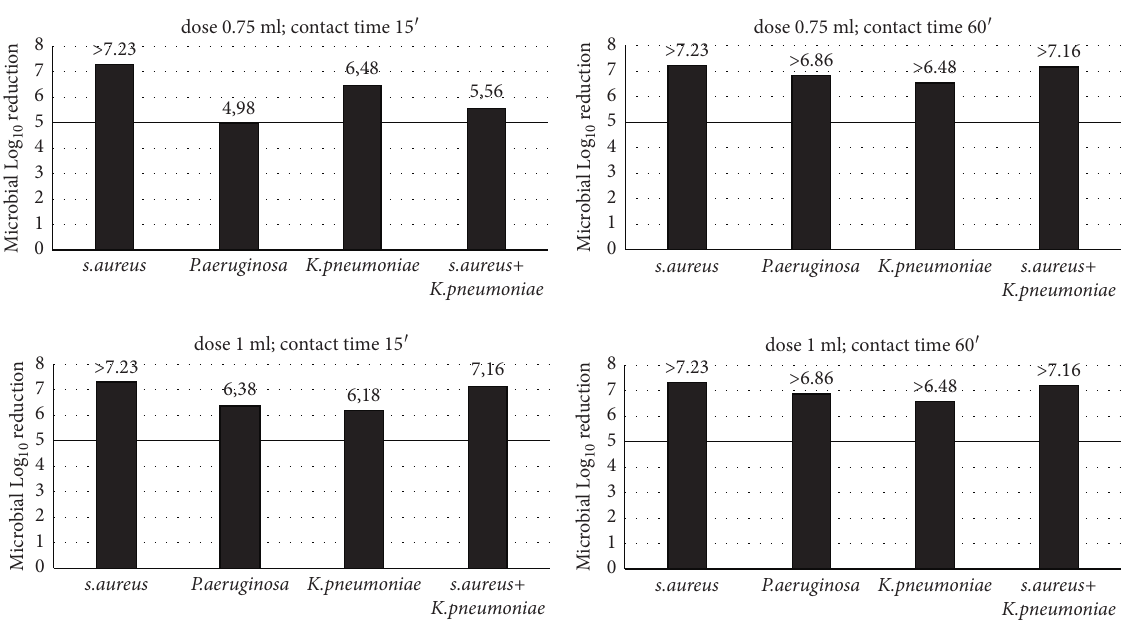
Figure 2: Antimicrobial activity of two doses of Fitostimoline ® Plus spray for two different contact times 15’ and 60’ against microbial suspension in the presence of organic material (FBS) of S. aureus , P. aeruginosa , K. pneumoniae , and a mix of S. aureus and K. pneumoniae . The results are expressed as microbial log10 reduction measured in terms of remaining alive colony-forming units (CFUs) after the product’s action. The horizontal black limit line indicates 99.999% bacteria